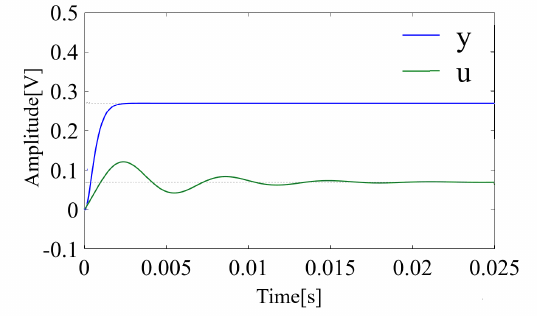
Figure 6. Step response of the digital controller designed by the PIM